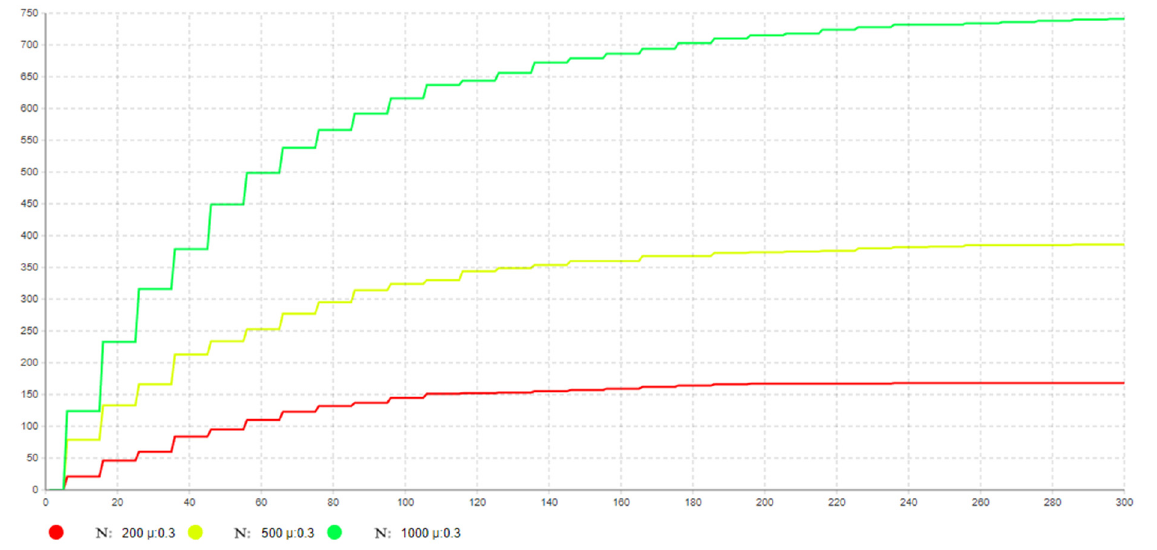
Figure 2. Influence of CID on BCW under different market sizes.4.2. Influence of CID on BCW under Different Communication Intensities